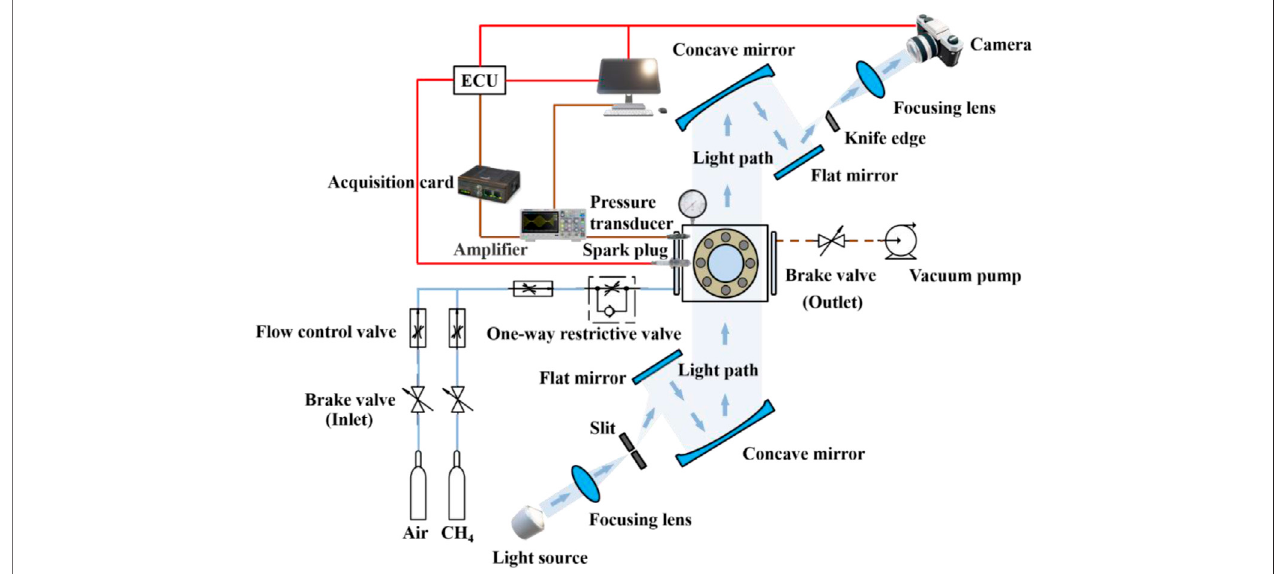
FIGURE 1 | Experimental equipment of constant volume combustion bomb.